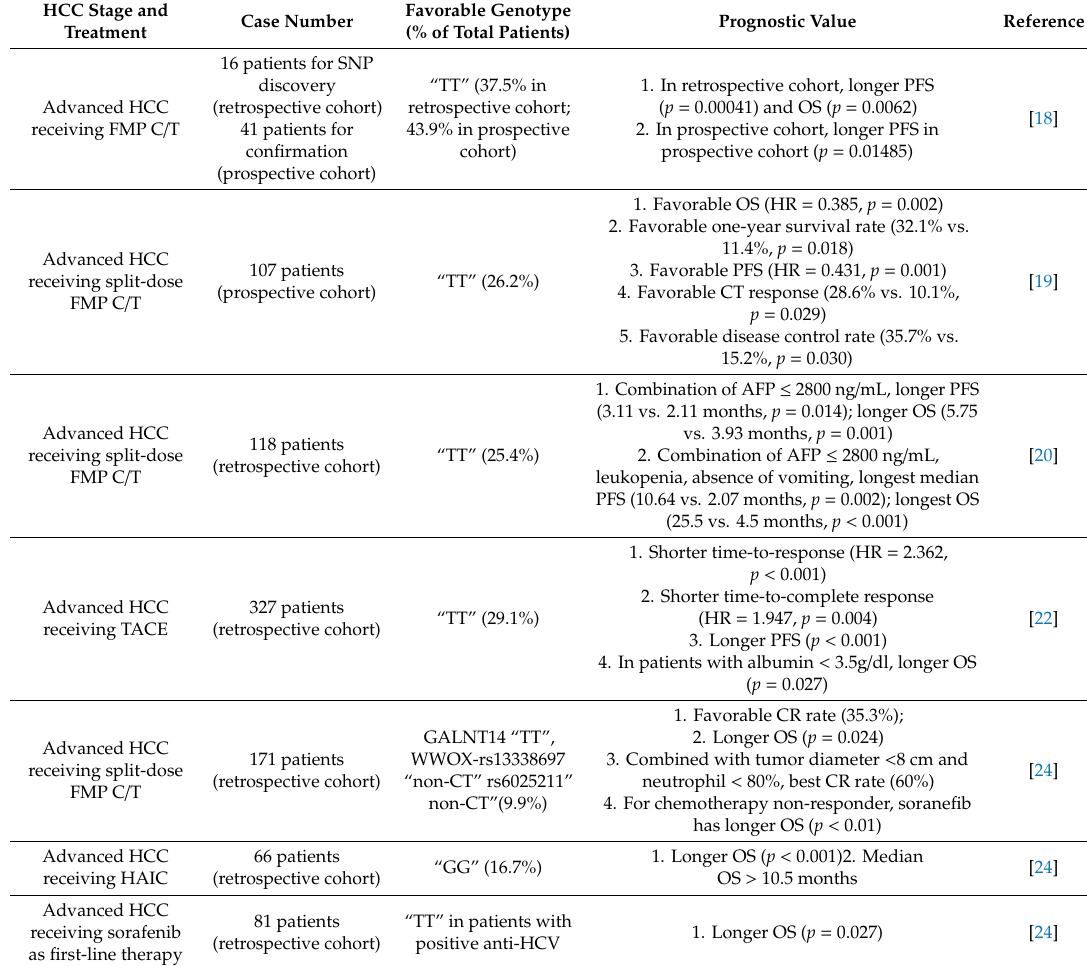
Table 1. GALNT14 SNPs at di ff erent HCC stages and